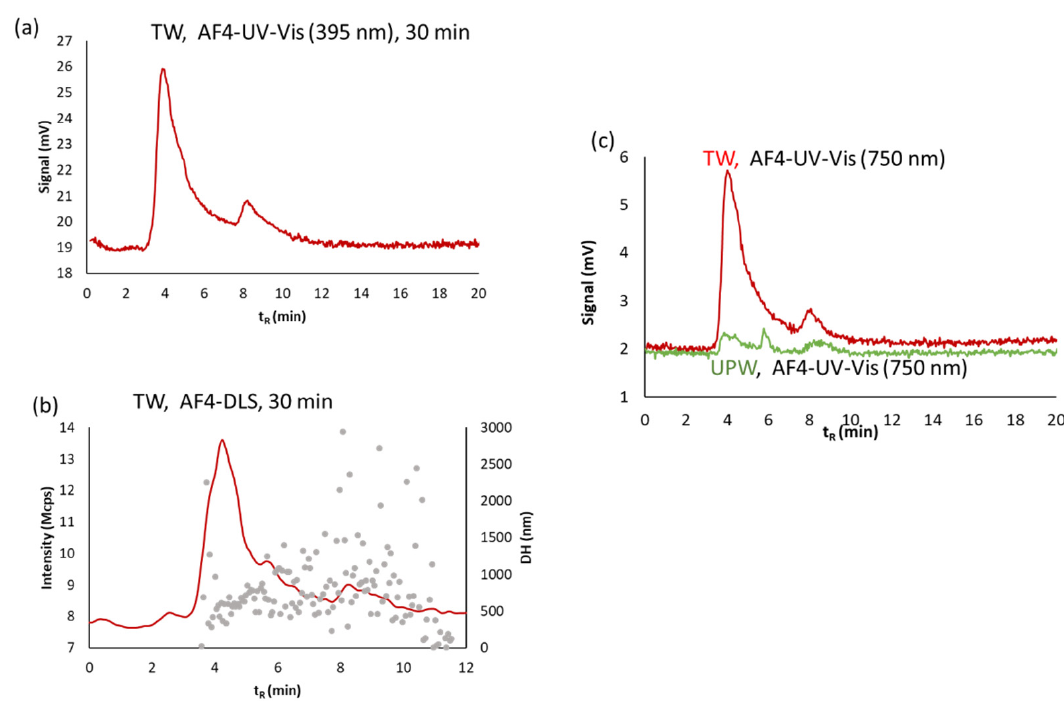
Figure 10. AF4 coupled in series with UV-Vis and DLS detectors for batch O2 diluted 1/4 with tap (TW) water measured at 30 min: ( a ) fractograms at 395 nm; ( b ) DLS fractograms; ( c ) Fractograms at 750 nm of TW and UPW. Crossflow was 0.2 mL·min − 1 .